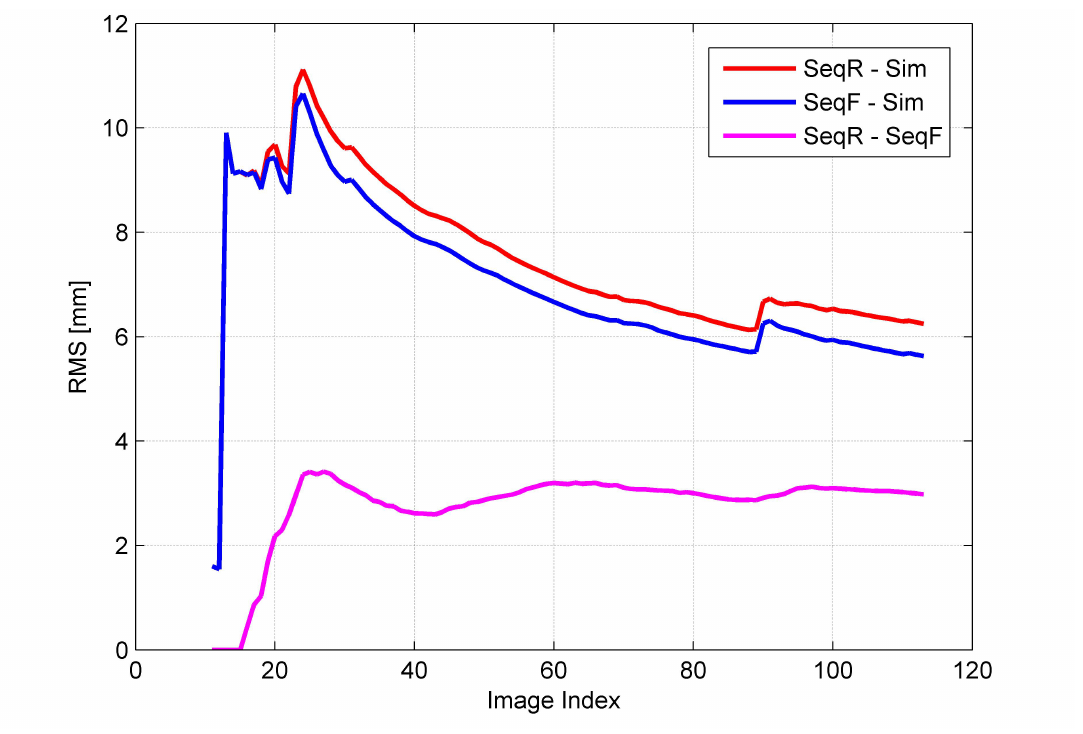
Figure 15. RMS values of EOP differences